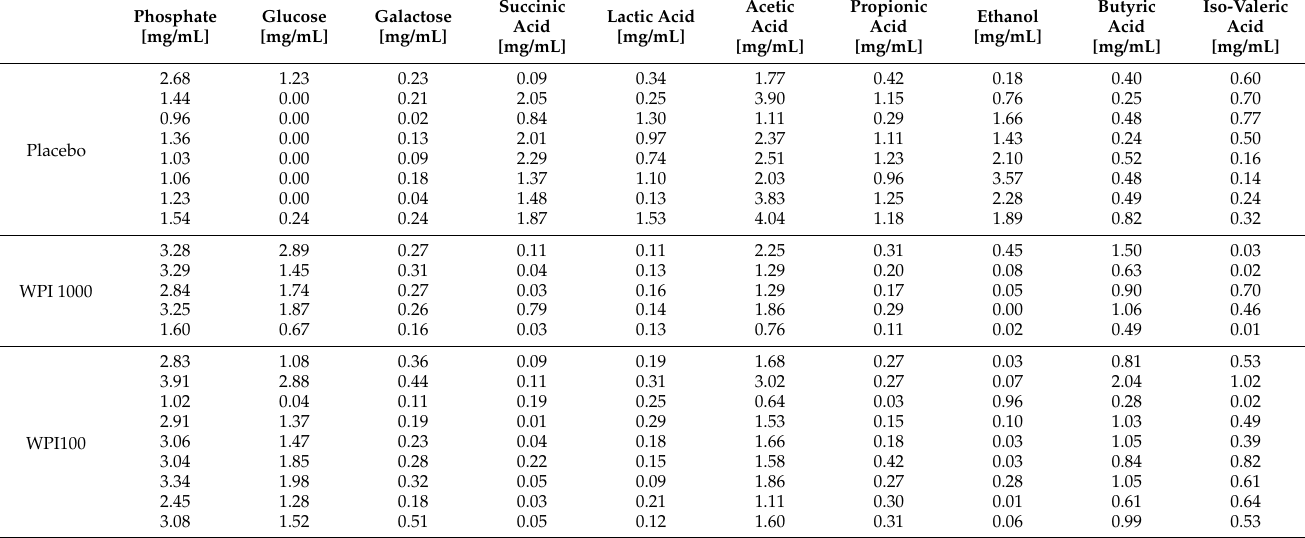
Table A1. Concentration of Different Metabolites in Intestinal Fluid Measured by RP-HPLC. Phosphate